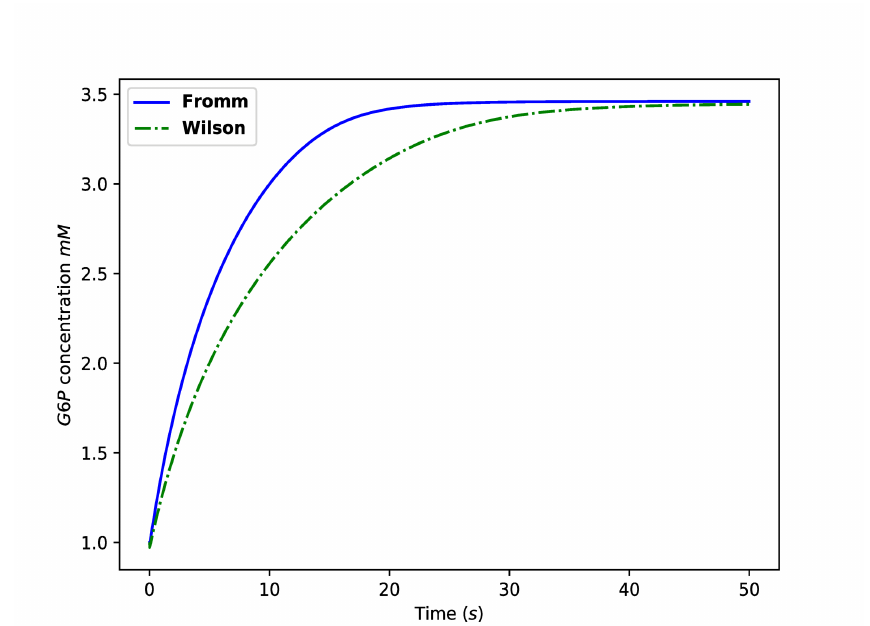
Figure 13. An illustrative calculation comparing the predictions of the Wilson and Fromm models. Such calculations may assist experimental studies in identifying the correct model, as explained in the Conclusions Section. The Fromm model here is the model described in the current paper. The Wilson model is the same as the Fromm model except now G 6 P can only bind to the N -binding site. The Fromm curve was generated using the parameter values displayed in Tables 2 and 3 and initial concentrations [ P i ]( t = 0 ) = 5 mM, [ G 6 P ]( t = 0 ) = 1 mM. The Wilson curve was generated using the same parameter values, except for k − G 6 = 180 s − 1 , k G 6 = 0 mM − 1 s − 1 , k − G 6 = 0 s − 1